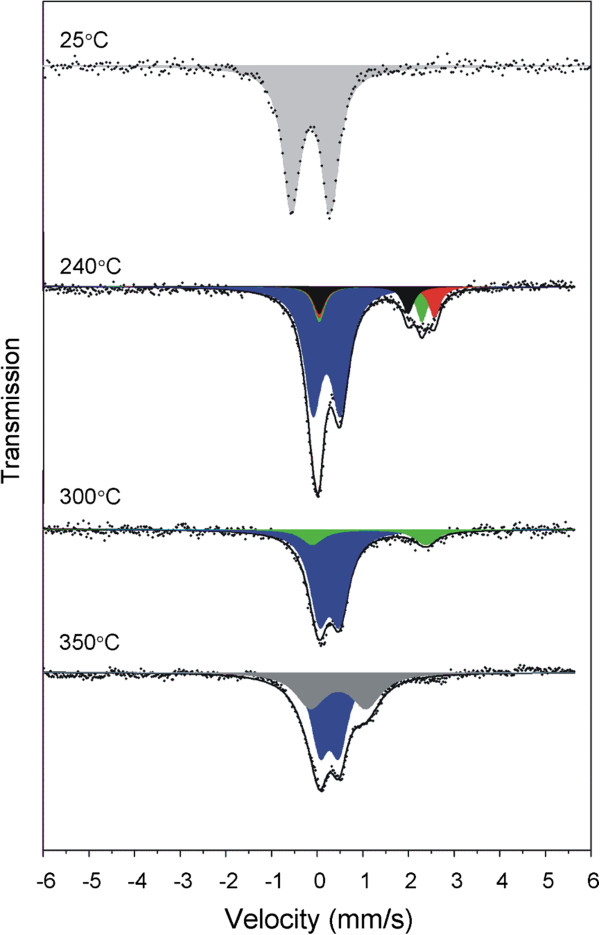
A representative Mössbauer spectrum of [Co(en)3][Fe(CN)6]⋅ 2H2O (1a) at 25°C and spectra of the converted intermediates formed by heating of 1a up to 240, 300 and 350°C.